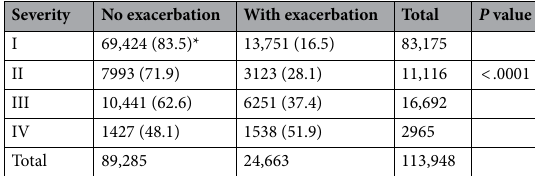
Table 3. Exacerbation in the following year according to severity of total study population. *Percentage of patients by exacerbation (%).